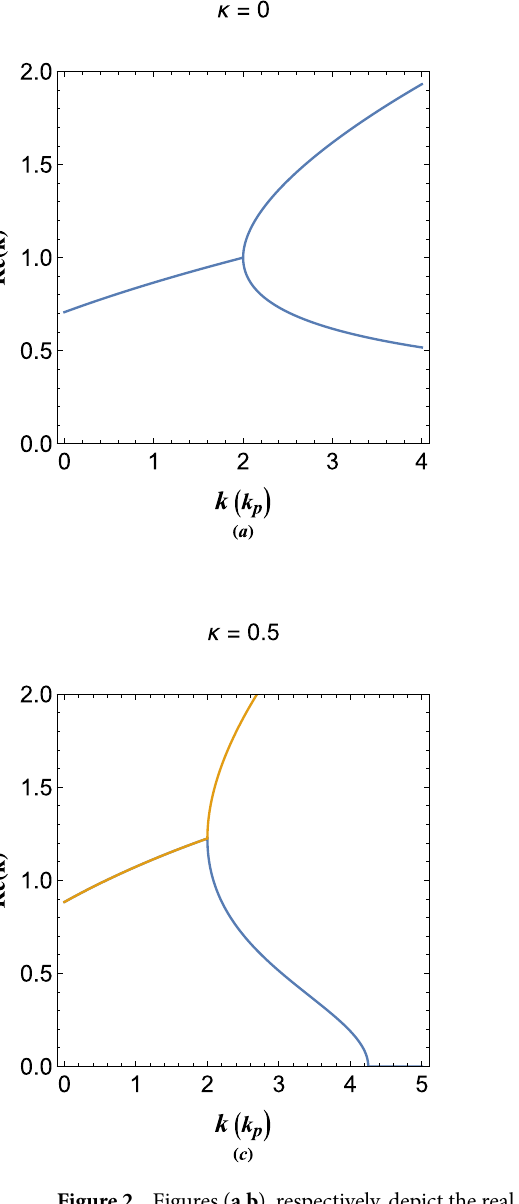
Figure 2. Figures ( a , b ), respectively, depict the real and imaginary parts of the energy dispersion of collective quasiparticle modes of undamping plasmon excitations. Figures ( c , d ), respectively, depict the real and imaginary parts of the energy dispersion of collective electron modes in the presence of damped plasmon excitations effect ( κ = 0.5